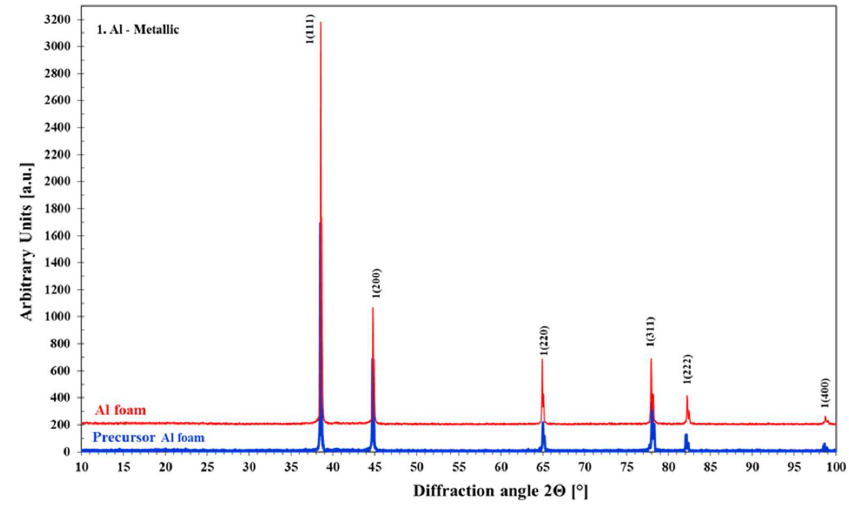
Figure 11. X-ray diffraction pattern for the precursor specimen and Al-foam specimen sintered at 740 °C.